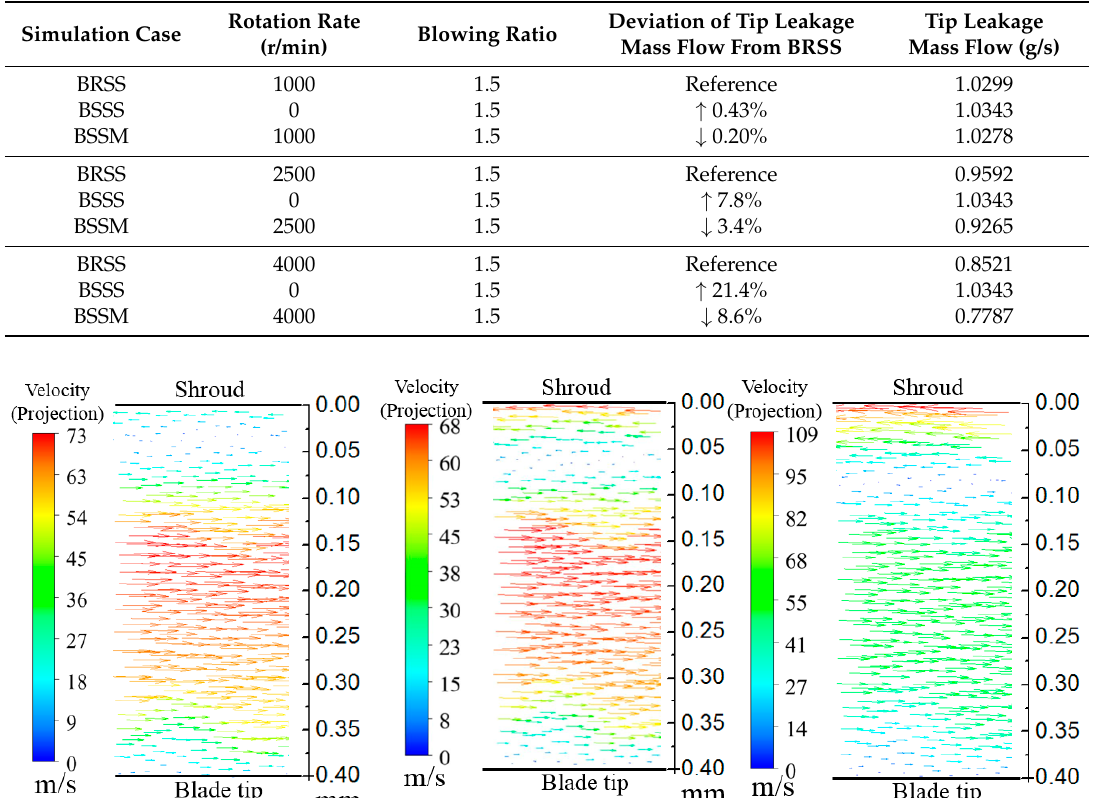
Table 3. Tip leakage mass flow rates in the three simulation cases at different rotation speeds.